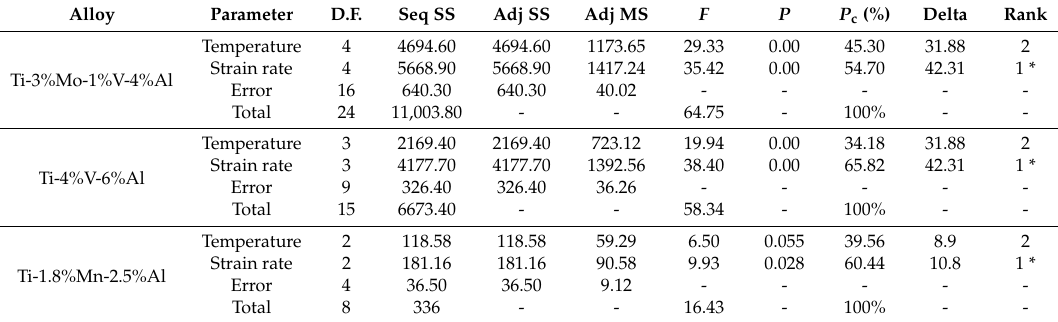
Table 5. Analysis of variance for the mean of the σ s